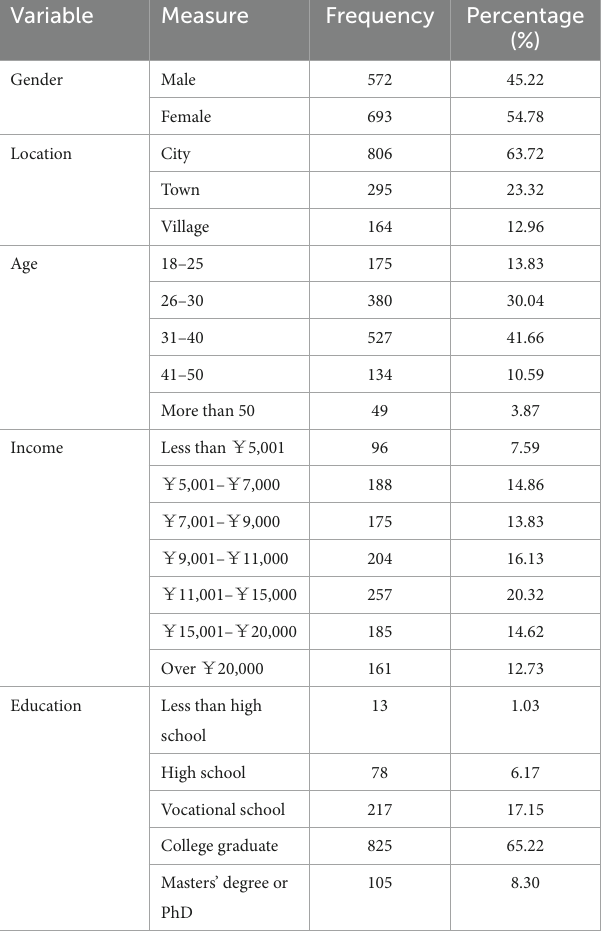
TABLE 1 Demographic profile of respondents ( n =